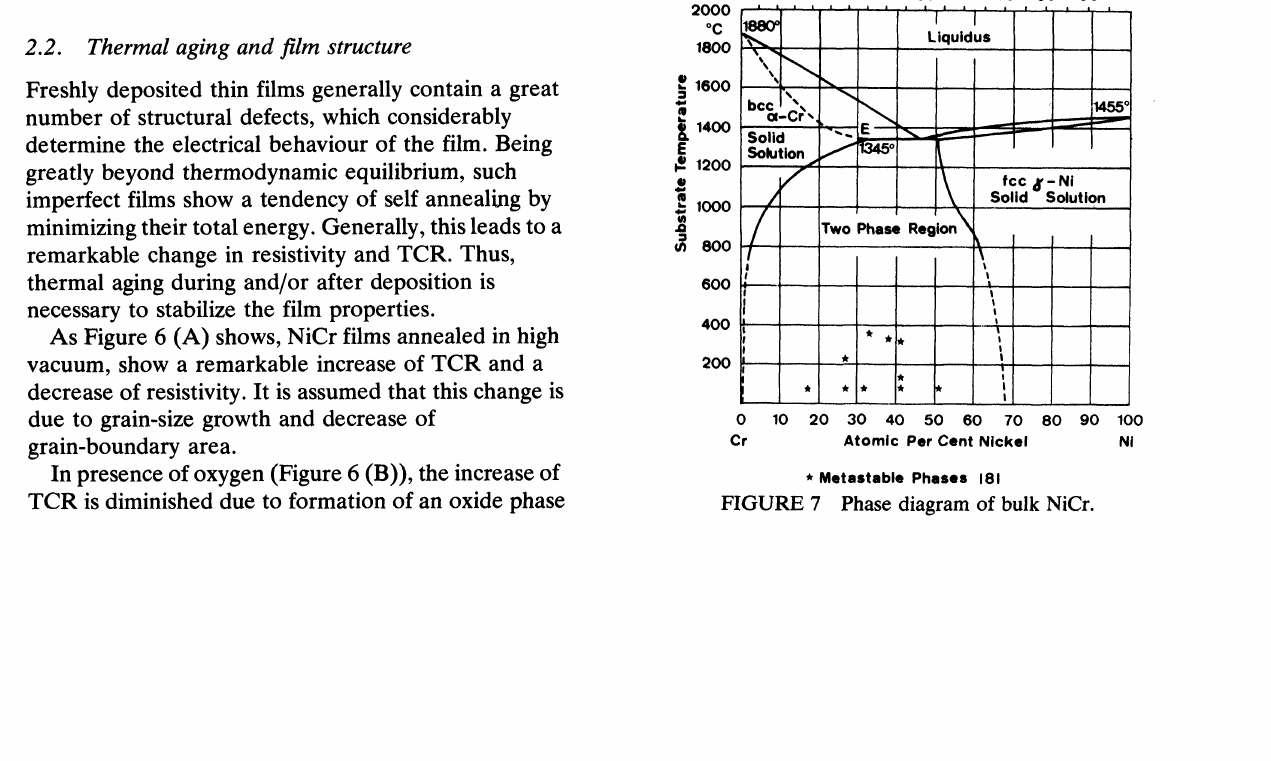
FIGURE 5 Influence of 0 time on TCR. Annealling temperature" 350C.